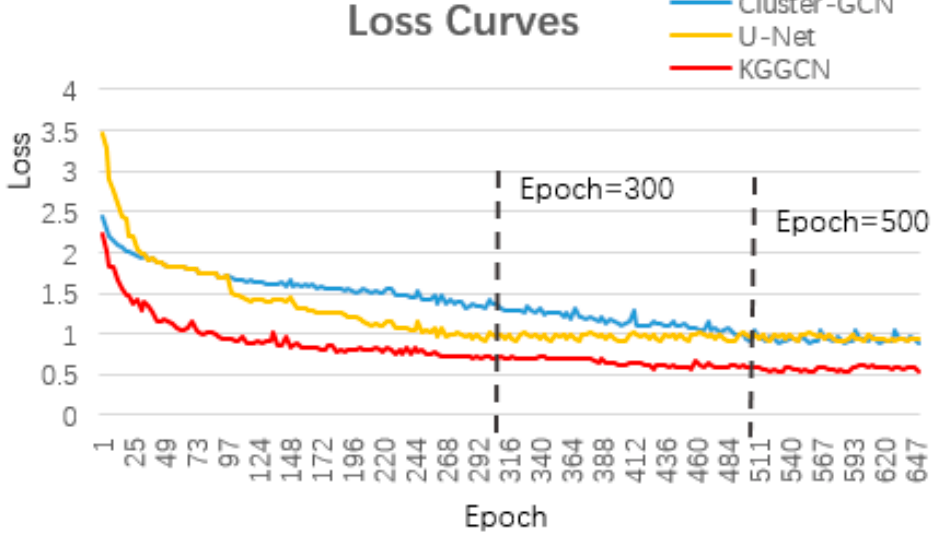
Figure 15. Loss curves of the three models: Cluster-GCN, U-Net, and KGGCN. The x-axis is the training epoch and the y-axis is loss.